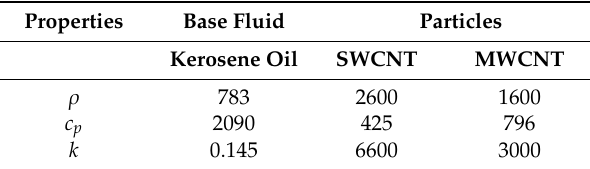
Table 1. Data of thermophysical properties for the given particles and fluid. MWCNT, multi-walled carbon nanotube; SWCNT, single-walled carbon nanotube.